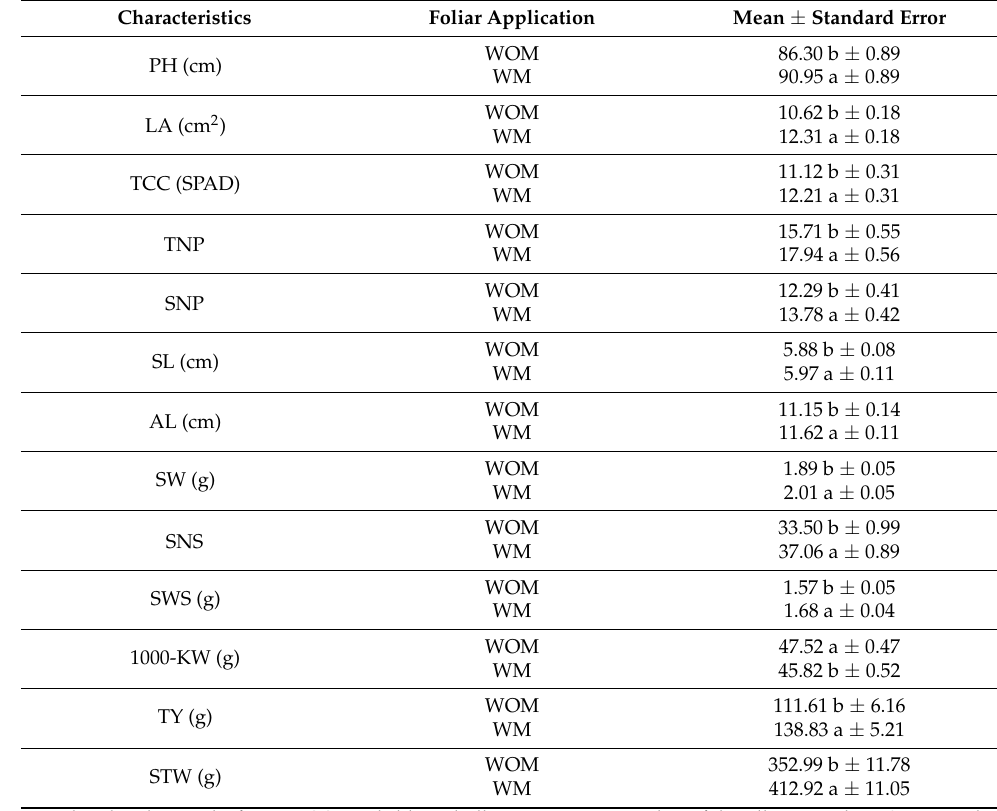
Table 3. Pairwise comparisons (Duncan) of different studied characteristics under treatment with MOE (WM) versus control conditions